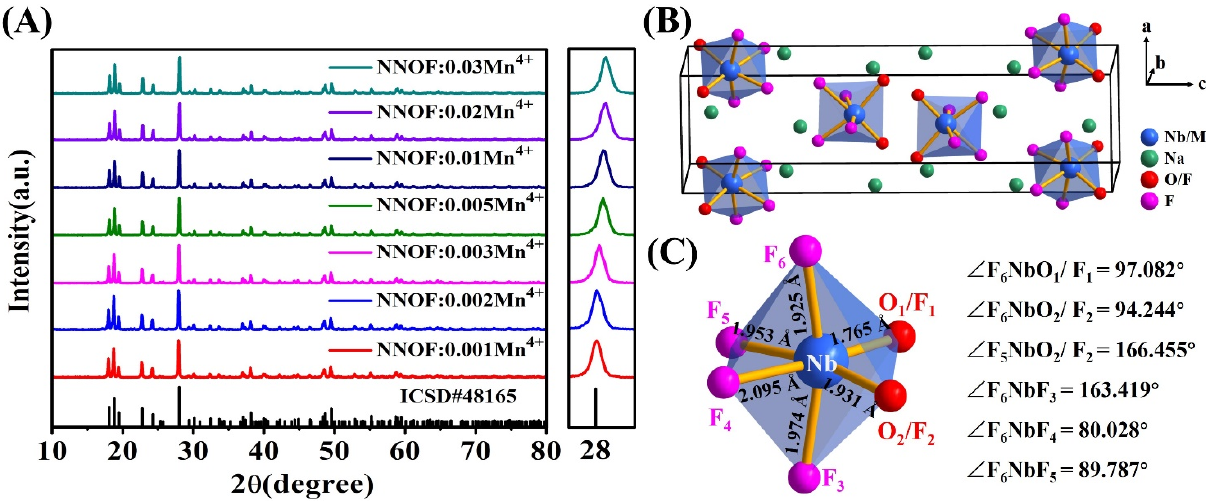
Figure 2. ( A ) XRD patterns of NNOF: x Mn 4+ and enlarged XRD patterns in 2 θ region of 27.5–28.5°; ( B ) Crystal structure scheme of NNOF:Mn 4+ ; ( C ) Demonstration of the distorted [NbOF 5 ] 2 − octahedron.